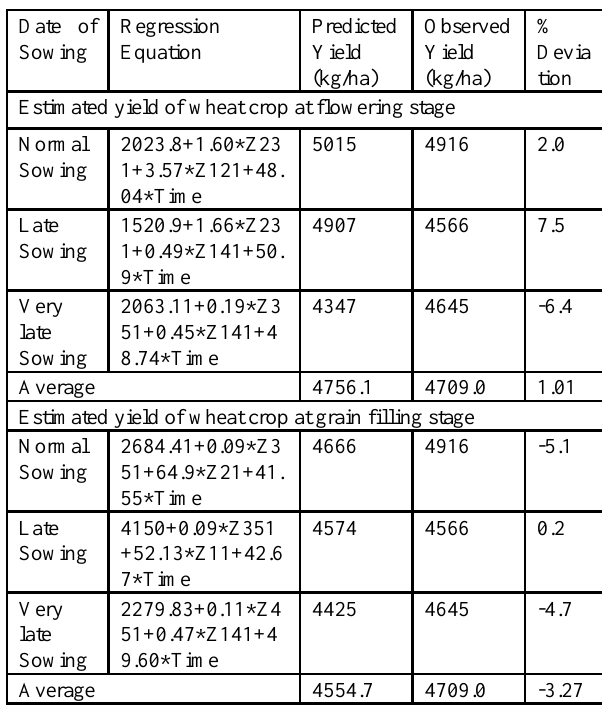
Table 1: Percentage deviation of observed yield from estimated yield of wheat crop by weather based model ( Rabi 2016-17)